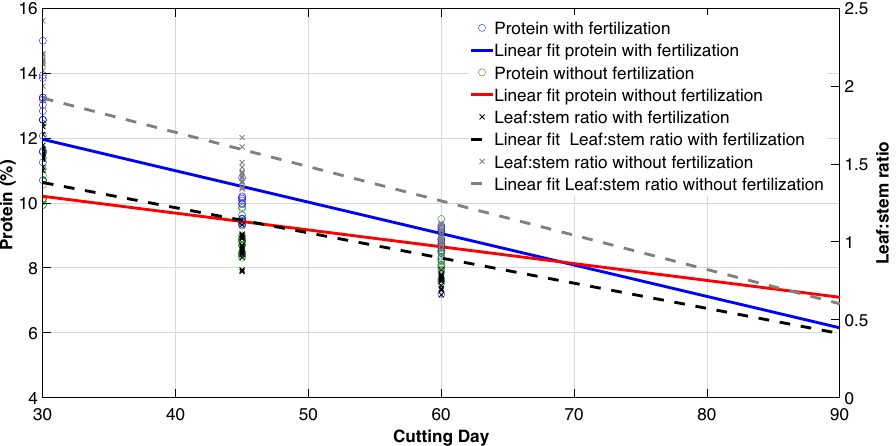
Figure 3. Linear relationship between protein and leaf: stem ratio of King grass on different cutting days and in systems with and without fertilization. Plots were created in MATLAB R2021a. Lineal regression equations (C = Cutting day): Protein with fertilization = − 0.0968C + 14.8642. r 2 = 0.8491, n = 63, P < 0.001. Protein without fertilization = − 0.0519C + 11.7607. r 2 = 0.7271, n = 63, P < 0.001. Leaf: stem ratio with fertilization = − 0.0162C + 1.8657. r 2 = 0.7986, n = 63, P < 0.001. Leaf: stem ratio without